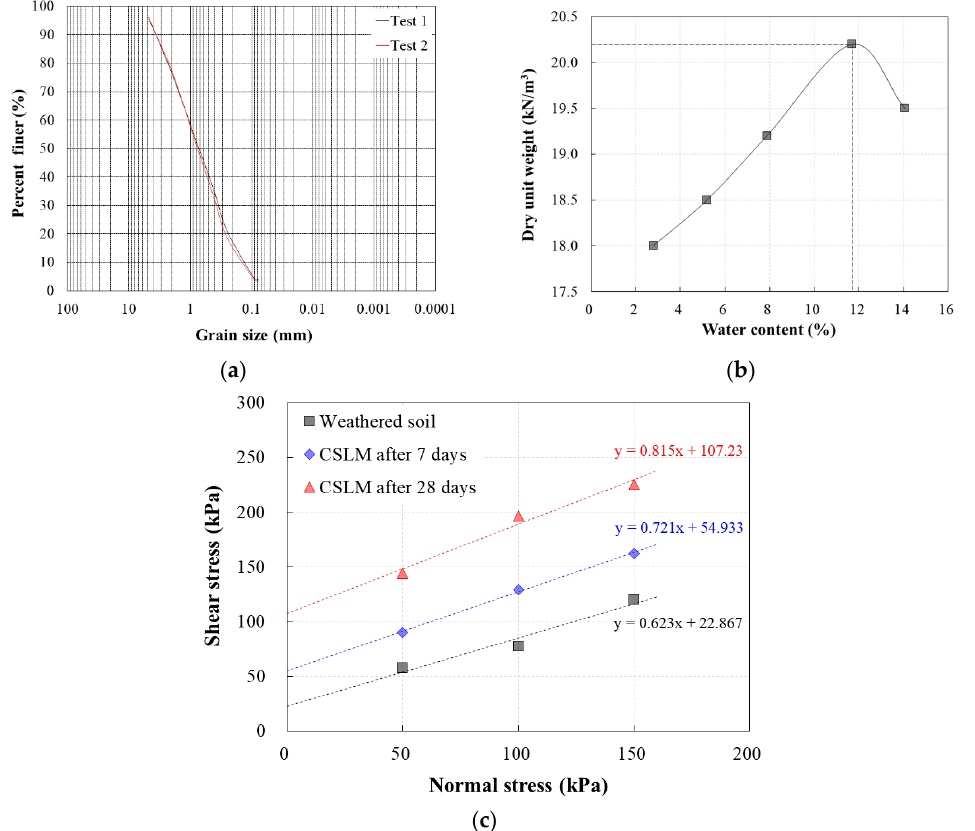
Figure 11. Engineering properties of weathered soil and CLSM: results of ( a ) sieve analysis of weathered soil; ( b ) compaction tests of weathered soil; ( c ) direct shear test.